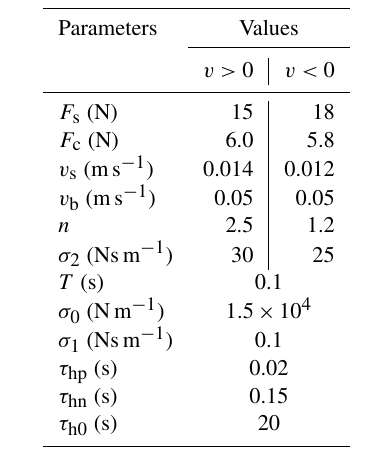
Table 2. Values of the parameters of the three models used in sim- ulation.